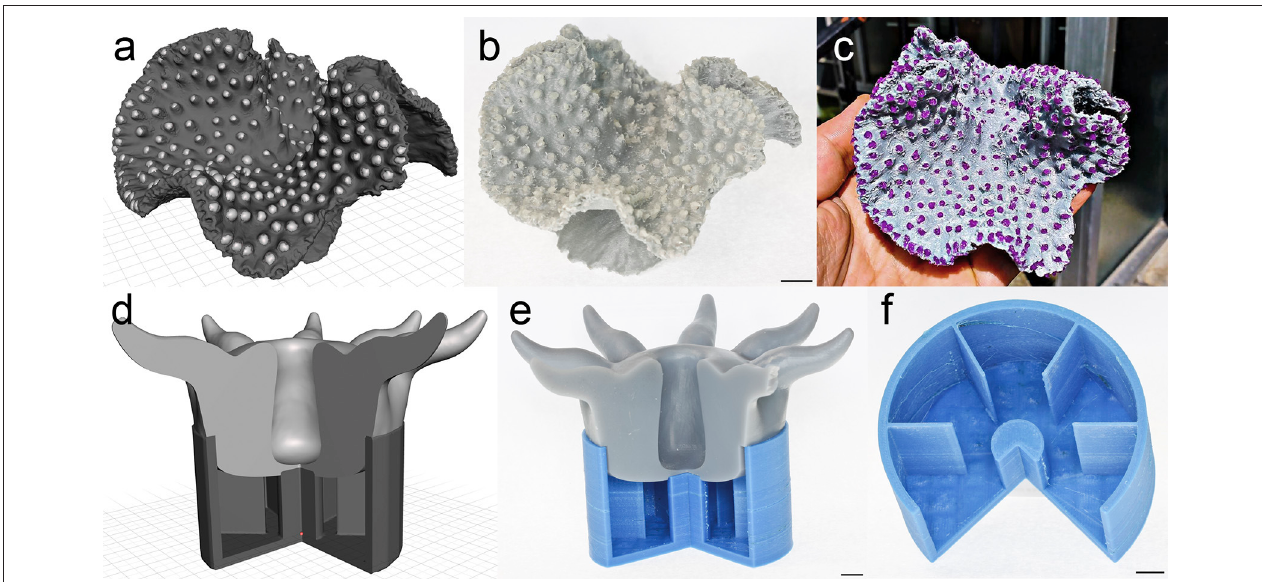
FIGURE 10 | CAD design in the aid of 3D coral printing for sensing research and education. (a) 3D model of Turbinaria sp. colony from laser triangulation imaging for corallite inclusion by design. (b) Silver PLA print of Turbinaria sp. colony with UV reactive PLA corallites. (c) Silver PLA print of Turbinaria sp. colony with UV reactive PLA corallites under direct sunlight. (d) 3D model of idealised corallite theca and polyp for education purposes. (e) PLA print of assembled corallite theca and polyp. (f) PLA print of corallite theca showing septa. Scale bars represent 1cm.